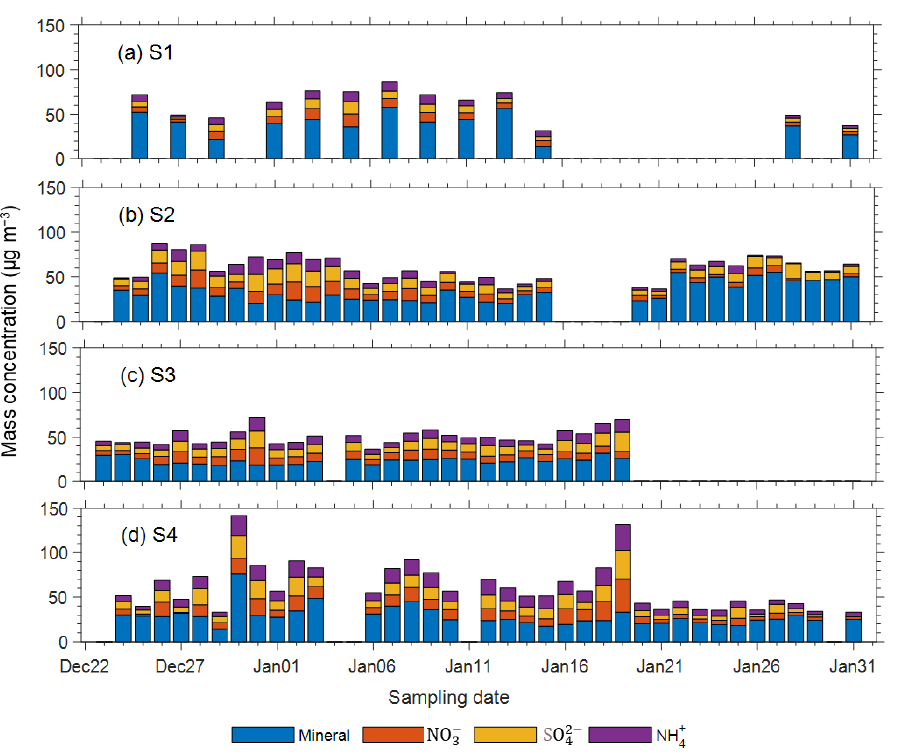
Figure 4. Temporal variations of mass concentrations of the mineral and secondary inorganic aerosols (SO 42 − , NO 3 − , and NH 4+ ) in the daily PM 2.5 samples at sites S1 ( a ), S2 ( b ), S3 ( c ), and S4 ( d ). The secondary inorganic aerosols (SIA, including SO 42 − , NO 3 − and NH 4+ ), with